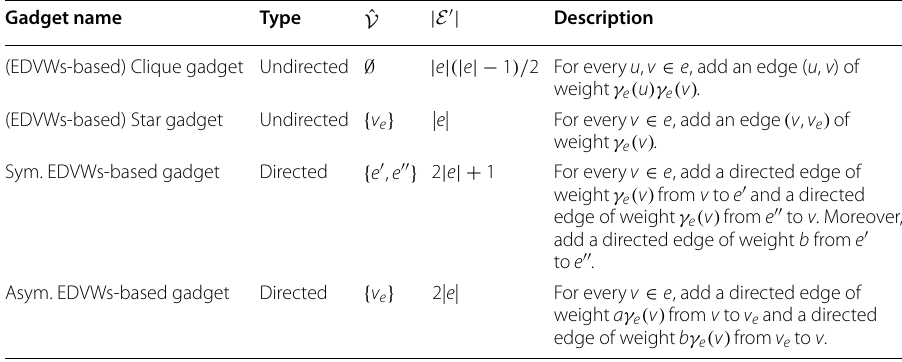
Table 2 Examples of gadgets G e = ( e ∪ ˆ V , E ′ ) incorporating EDVWs Gadget